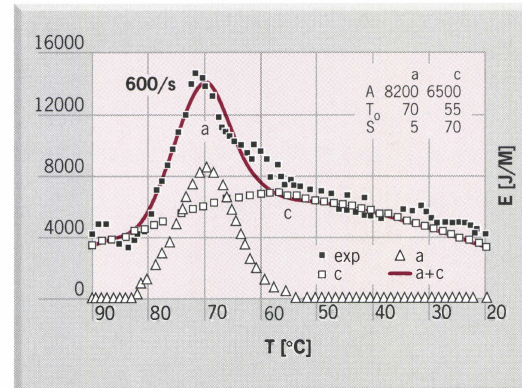
Fig. 4: Evolution of activation energy of flow during the cooling of maize starch